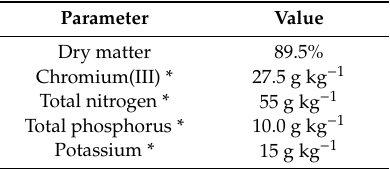
Table 1. Tannery sludge chemical–physical